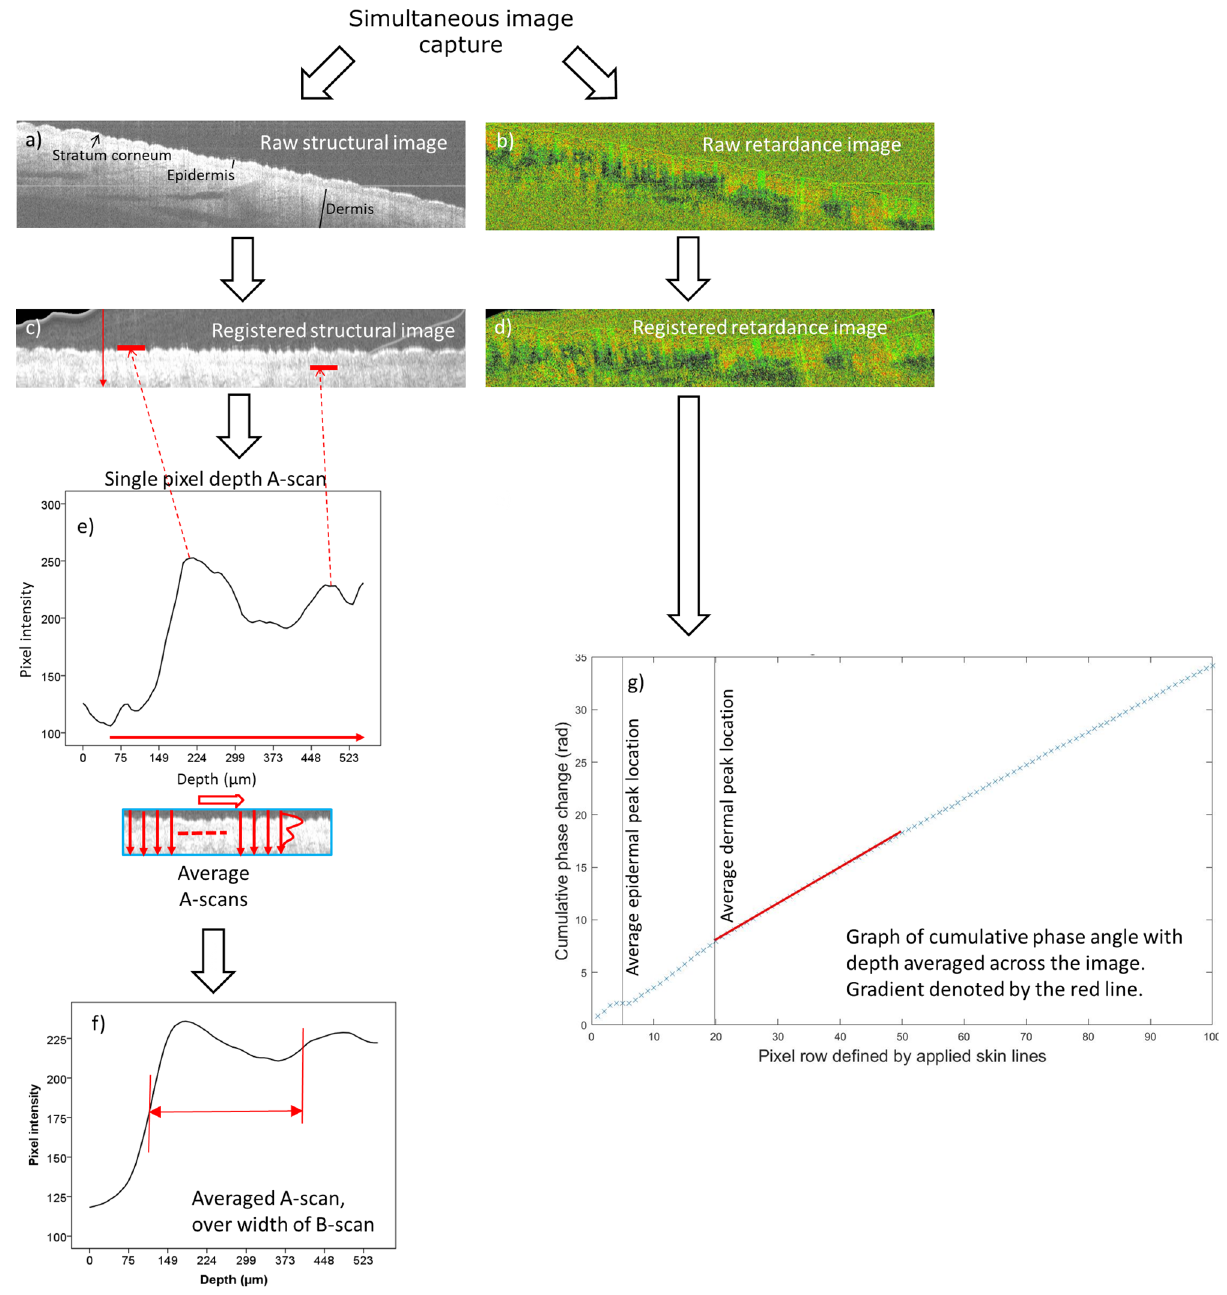
Figure 2. Image post-processing pathway. Examples of: raw PS-OCT B-scans for ( a ) structural (showing the layers of the skin beneath the surface) and ( b ) retardance images (birefringence manifests itself as observable skin heterogeneity and tissue organisation, heterogeneity here is due to the presence of structures such as sebaceous glands and hair follicles). Images ( a ) and ( b ) were generated in ThorImage 4.3; ( c , d ) Scans are registered to align slices and provide a horizontal skin surface. Registration is performed by smoothing each A-scan in the structural image and selecting the first peak as the skin-air boundary. The vertical alignment of each A-scan in the structural and birefringence images are then adjusted so the skin-air boundary lies in a horizontal line across the image (using bespoke software (written by the authors) in MATLAB (version R2020a, Mathworks Inc, Mass, USA)). This makes birefringence (retardance) analysis easier as rows of pixels in the registered images correspond to tissue of consistent depth beneath the skin. ( e ) A-scan [single pixel width depth profile] and ( f ) averaged A-scan taken across the B-mode image [i.e. averaging all the A-scans over the width of the image to give an averaged measure of where peaks reflected from layers with in the skin occur]. Epidermal thickness was defined as the distance between the depth at which the intensity of the first peak had reached half its maximum value (skin surface) and the depth at which the intensity of the second peak had reached half its maximum value (dermal–epidermal junction); marked as a red horizontal arrow. ( g ) Shows the cumulative retardance (phase change [radians]) plotted for skin depth (pixels) from skin surface to 100 pixels (shown without errors). The epidermal and dermal peak locations are shown as grey vertical lines. The gradient at the first 30 pixels from the dermal line (used to measure the differences between the groups) is indicated by the red